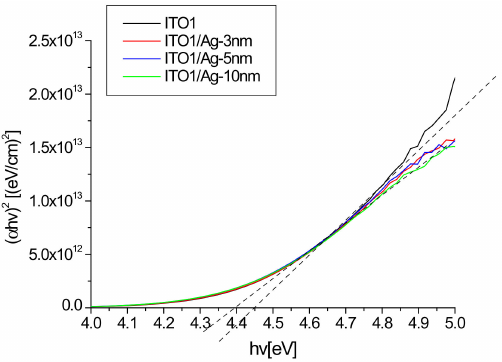
Figure 6. Absorption spectra of ITO1/glass and Ag/ITO1/glass in Tauc coordinates. It can be seen that the presence of silver slightly modifies the width of the optical band gap. The optical band gap values for all structures are presented in Table 2. Table 2. The values of E g for different Ag/ITO structures. ITO1 ITO2 ITO3 ITO4 Thickness of Ag layers [nm] E g [eV]